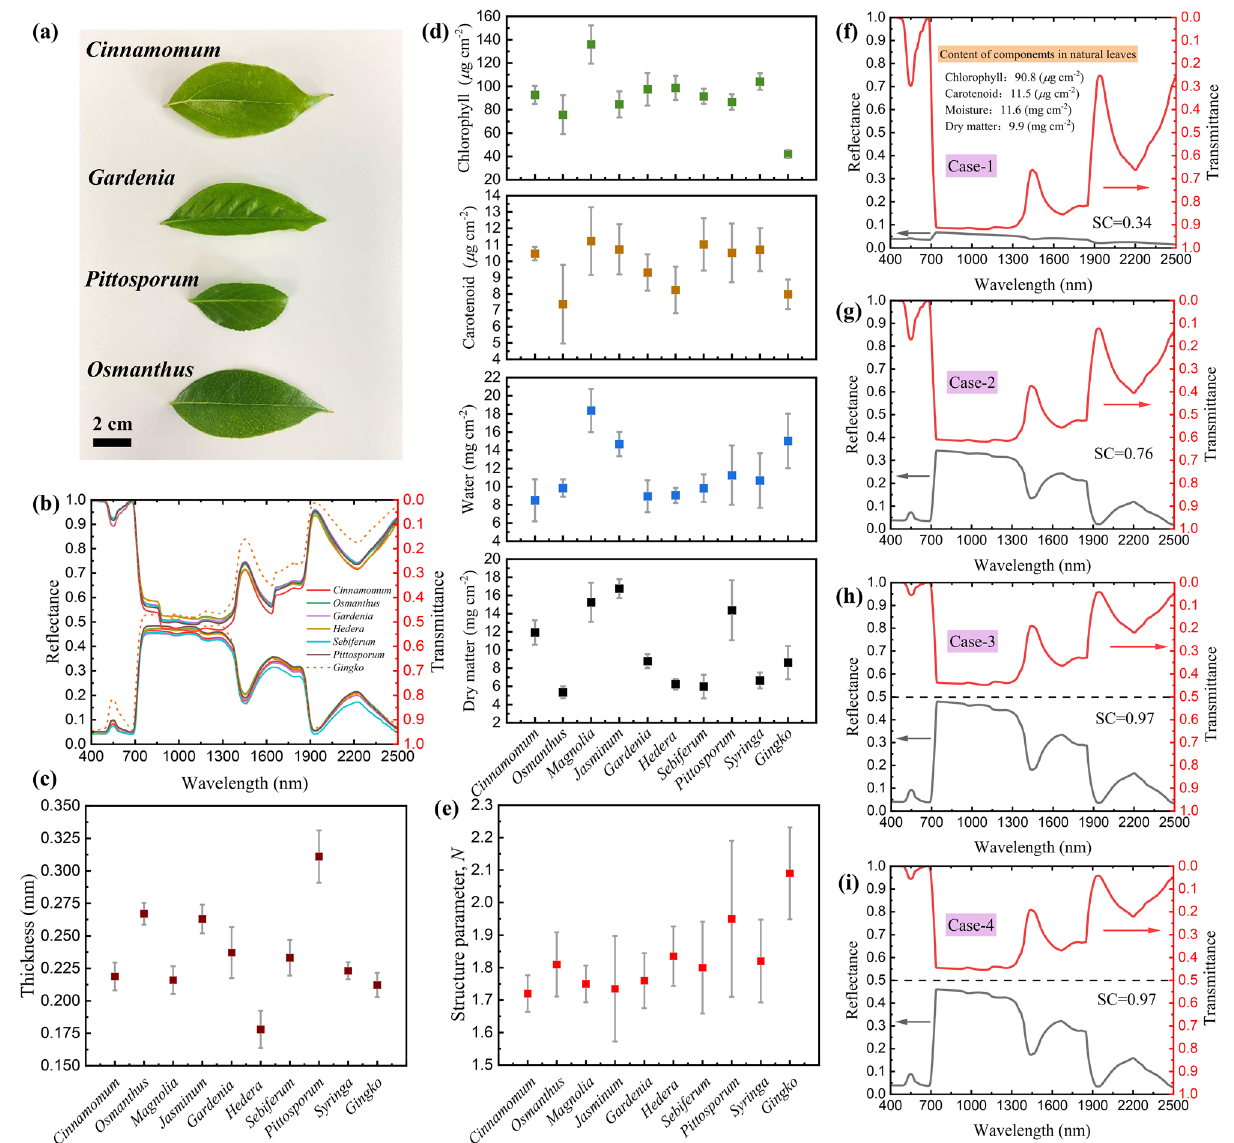
Figure 3. ( a ) Photos of the sample leaves. ( b ) Reflectance and transmittance of the natural leaves. ( c ) Leaf thickness of the natural leaves. ( d ) Contents of the components in the natural leaves, including chlorophyll, carotenoids, water and dry matter. ( e ) Structure parameter of the natural leaves. Calculated reflectance and transmittance of leaf with different structures, Case-1 ( f ), Case-2 ( g ), Case-3 ( h ) and Case-4 ( i ). The similarity coefficient (SC) of reflectance and transmittance is